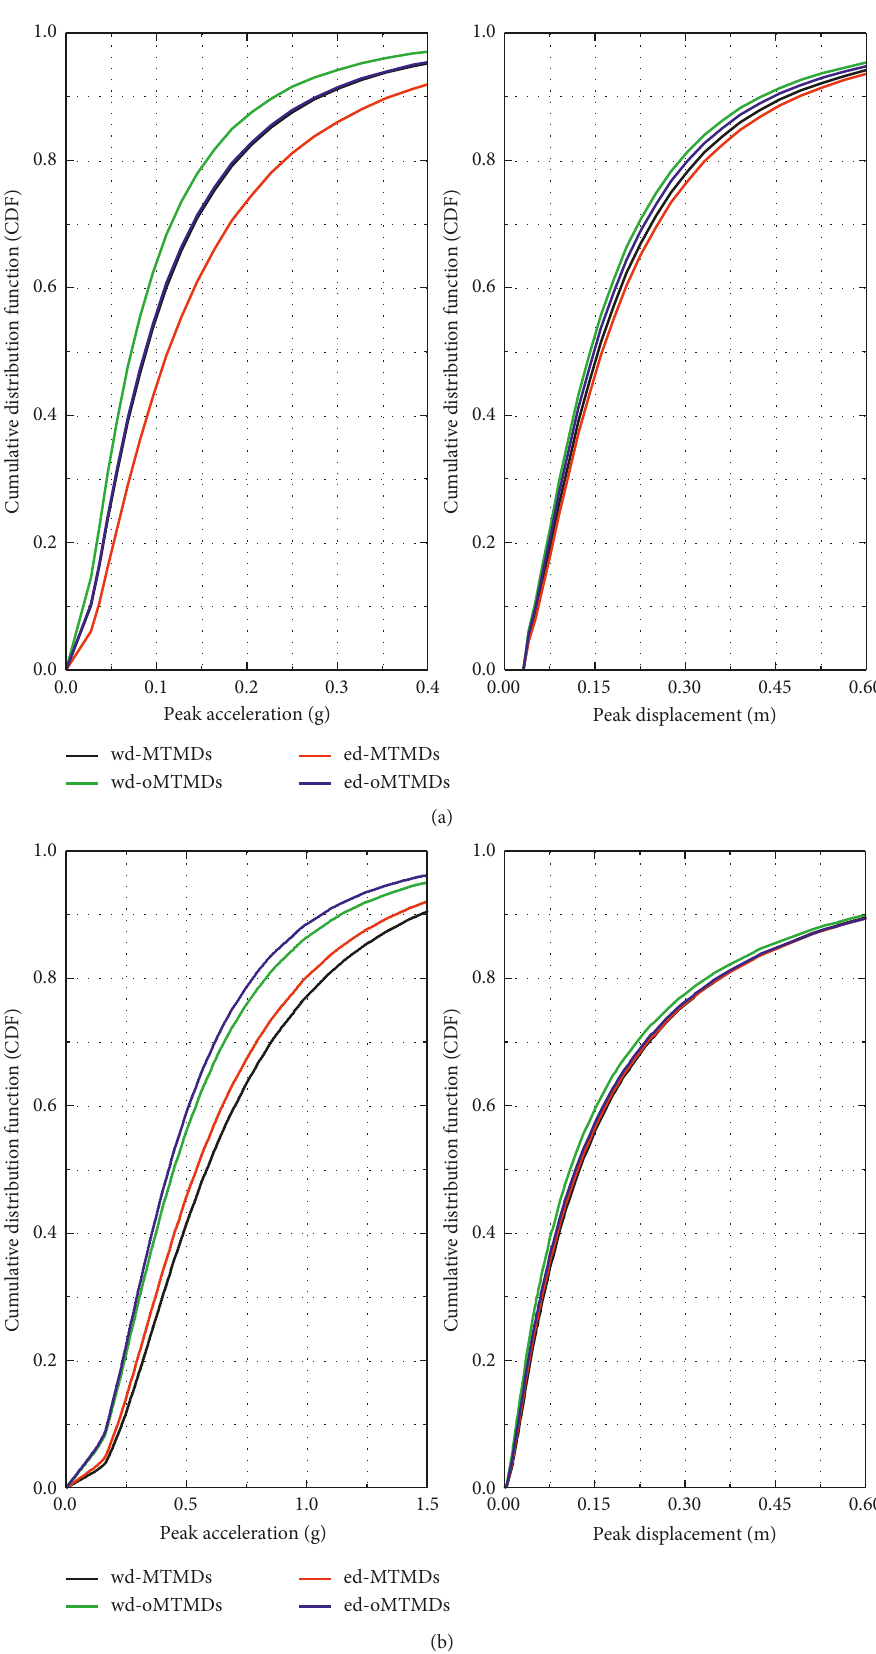
Figure 9: The CDF of responses for the wd-MTMDs, ed-MTMDs, wd-oMTMDs, and ed-oMTMDs subjected to wind (a) and earthquake excitations